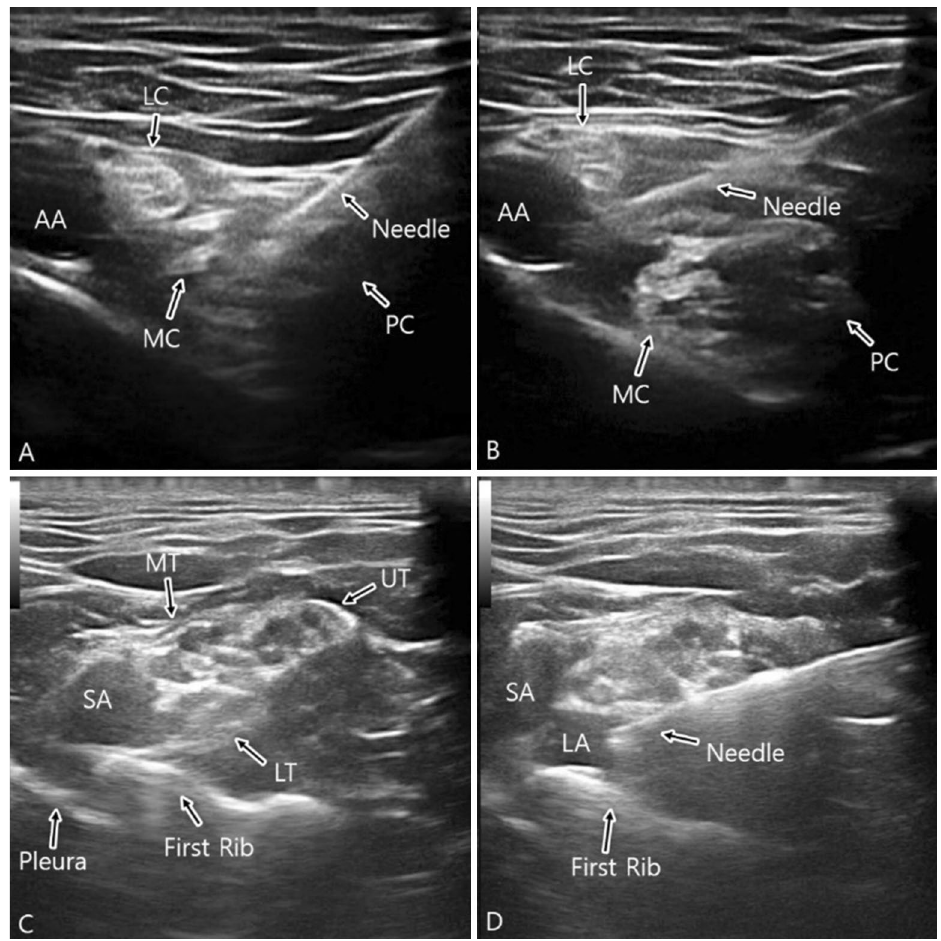
Figure 1. Sonographic view of costoclavicular ( A,B ) and supraclavicular ( C,D )